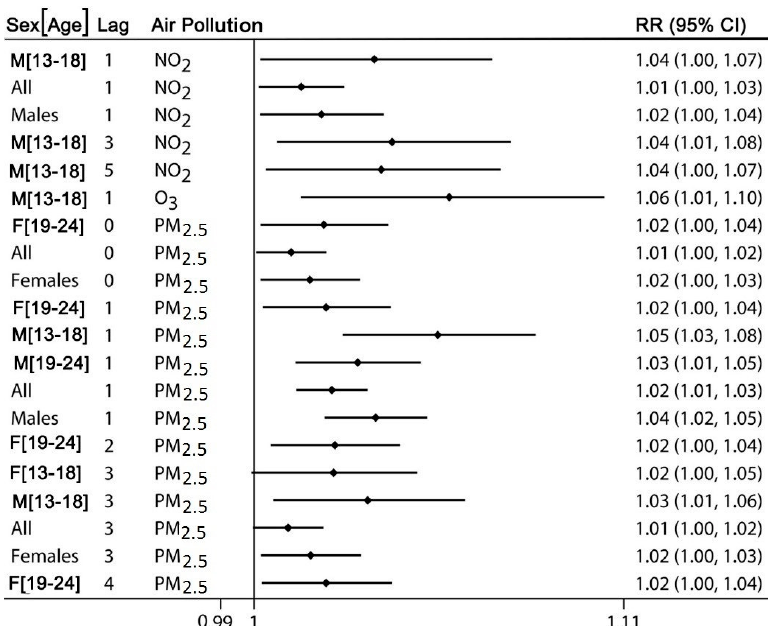
Figure 3. Relative risks (RR) and their 95% confidence intervals (CI) for positive statistically significant results. F—female, M—male. Lags are in days. Toronto, Canada, 2004–2015.